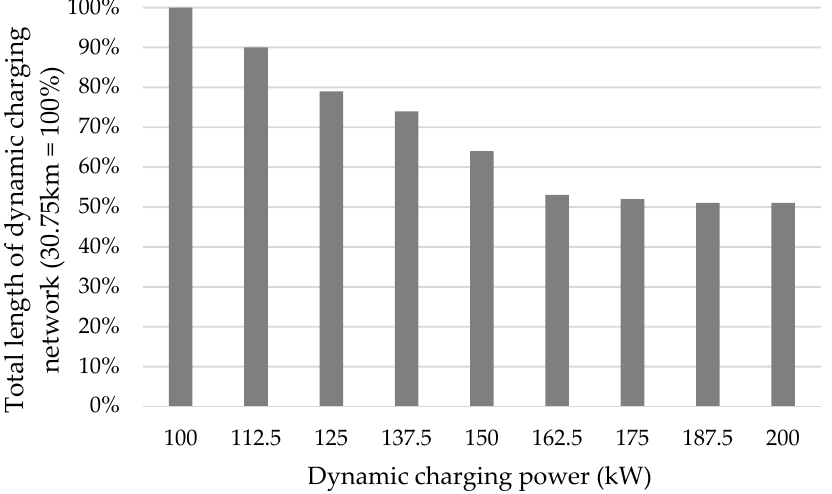
Figure 7. The total length of the dynamic charging network as a function of dynamic charging power (in Plan A).